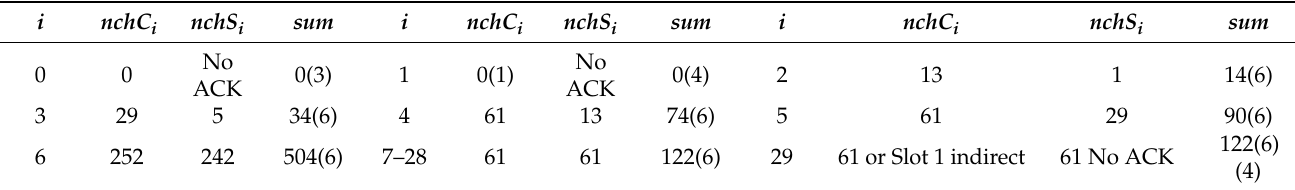
Table 1. The number of master and slave bytes for the 30 slots of the AC. Parentheses indicate control characters (2 × slot address + 2 × CRC16 (2 bytes) = 6